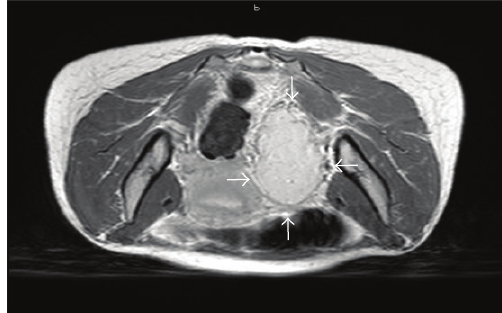
Figure 2: Pelvic MRI suggestive of a parauterine left site extra- adrenal sympathetic paraganglioma in the images obtained after i.v. injection of gadolinium: axial view.